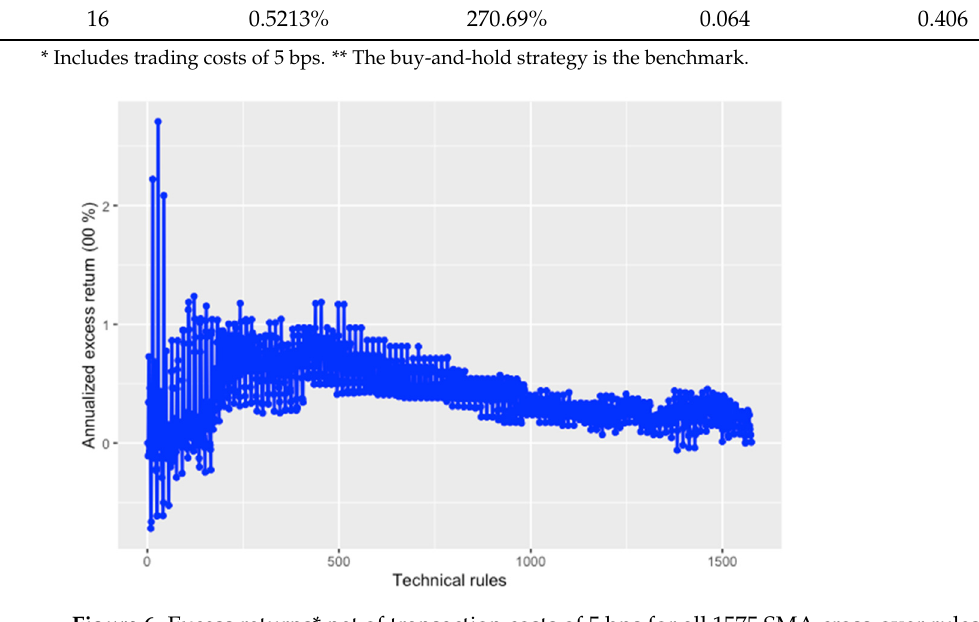
Table 4. Excess returns of the best performing trading rule on the Brent market during the COVID-19 pandemic (January 2020–March 2021) net of transaction costs